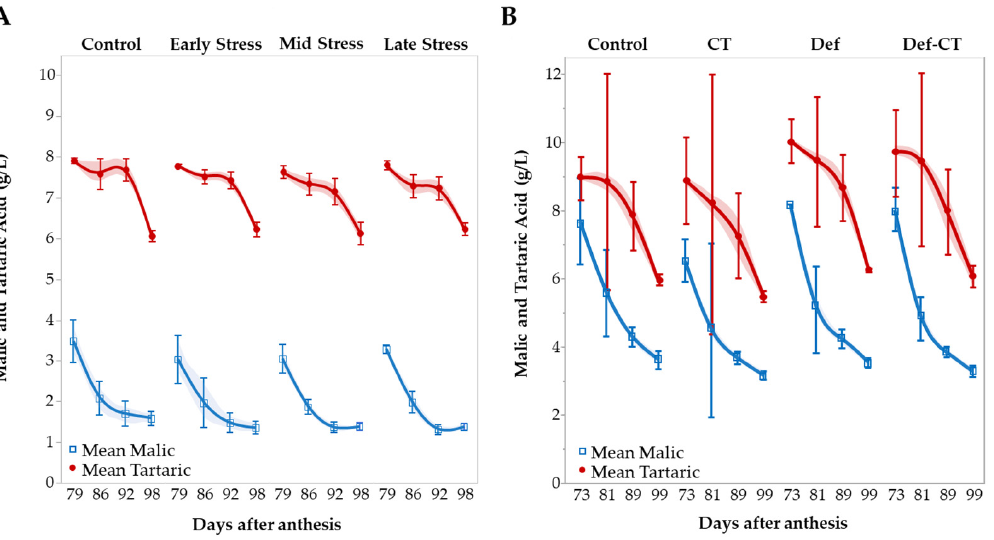
Figure 3. Development during ripening in tartaric and malic acid in water stress ( A ) and field trials ( B ). Keys: ‘Control’ = no treatment; ‘CT’ = crop-thinning; ‘Def’ = defoliation; ‘Def-CT’ = defoliation and crop thinning. Vertical bars indicate 95% confidence intervals. Shaded areas indicate 95% confidence of fit (spline function).